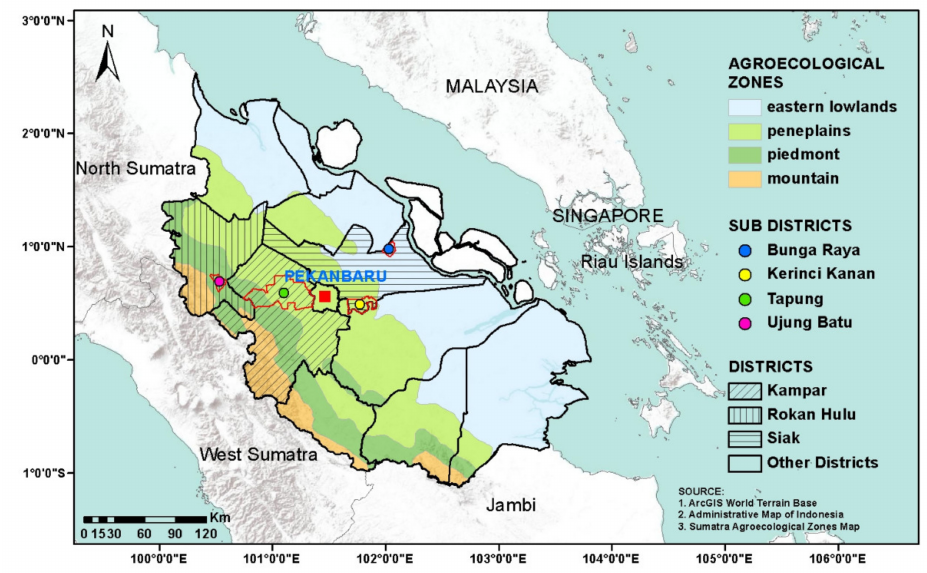
Figure 1. Riau Province, Indonesia, showing agro-ecological zones, district and sub-district boundaries, and the four study sites—Bunga Raya, Kerinci Kanan, Tapung, and Ujung